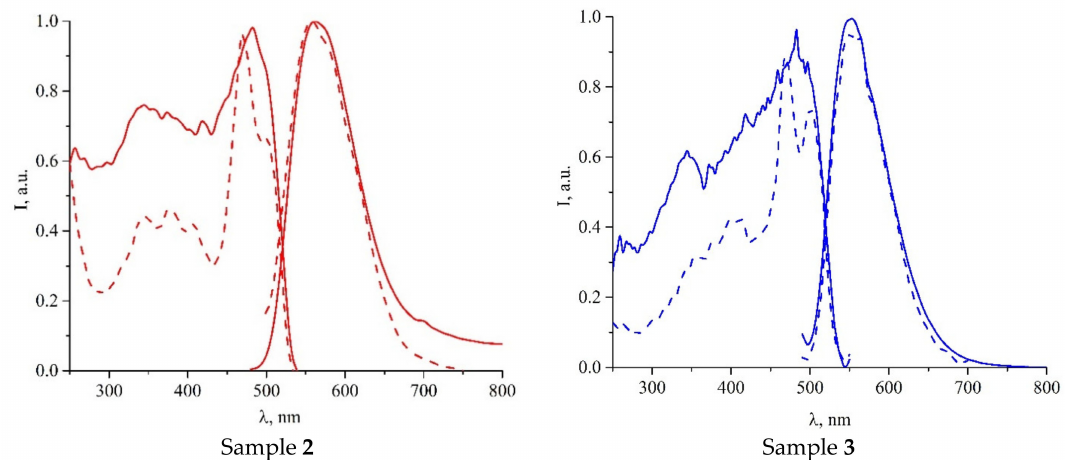
Figure 5. Normalized steady-state (solid lines) and delayed (100 µ s) excitation and emission spectra of solid samples 2 , 3 . Table 3. Main transitions in Py - btd molecule. f–oscillator strength, H—HOMO, L—LUMO,